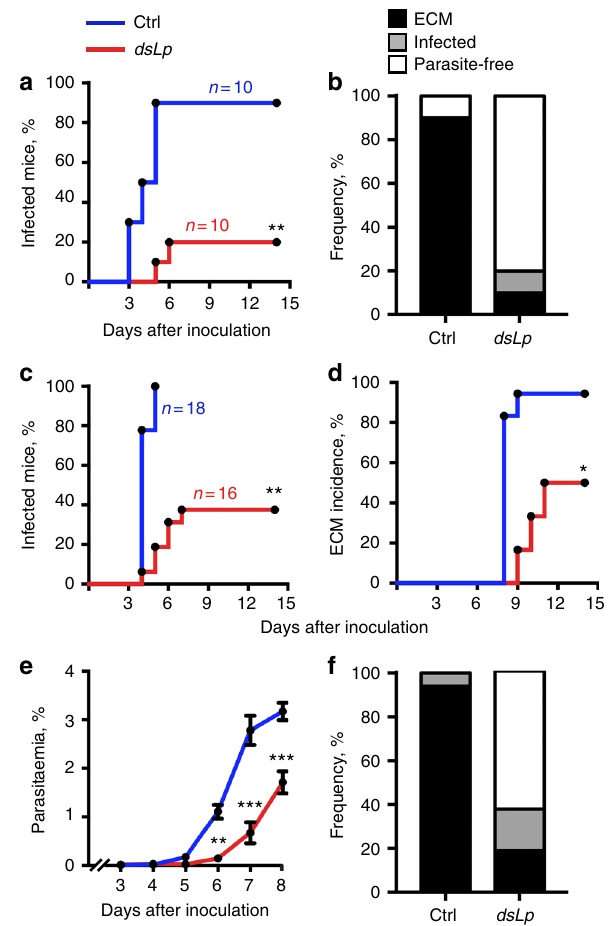
Fig. 2 Within-vector environment impacts within-host Plasmodium virulence. C57BL/6J mice bitten by P. berghei -infected mosquitoes ( a , b ) or infected by sporozoite injection ( c – f ) were daily monitored for parasite occurrence in the blood and for symptoms of experimental cerebral malaria (ECM). a Kaplan – Meier analysis of time to infection (blood